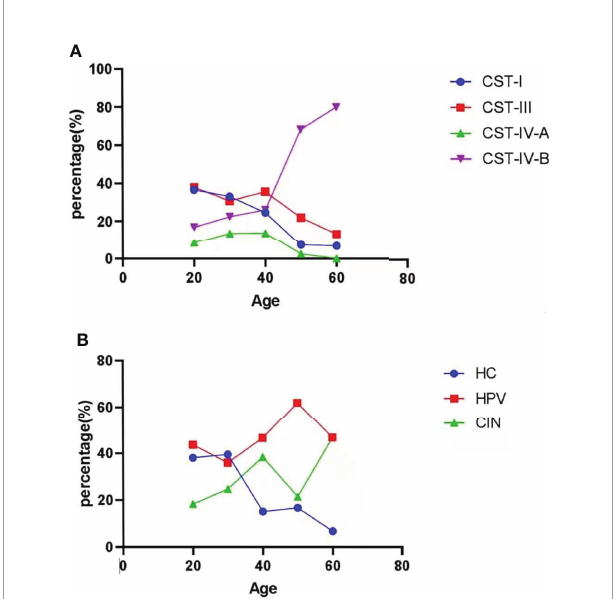
FIGURE 6 | HPV infection and CST subtypes based on age. (A) Different CST subtypes in all samples according to age. (B) HPV prevalence and CIN- diagnosed in all samples according to